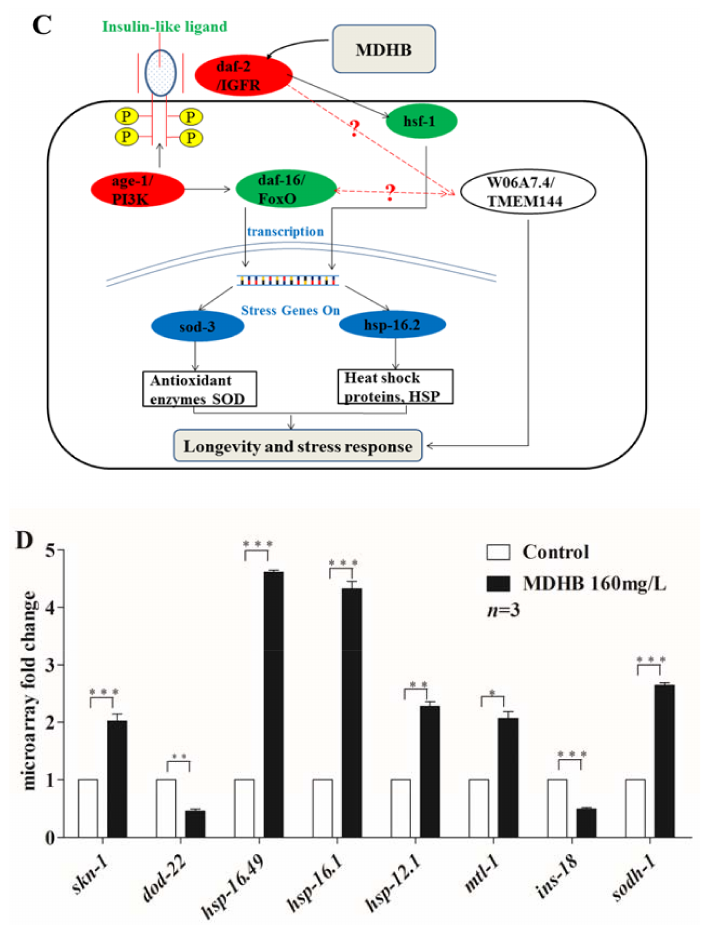
Figure 8. Influence of MDHB on the expression of daf-2/daf-16 target genes. ( A ) Influence of MDHB on survival rates of daf-16 (mu86) mutants under oxidative stress conditions induced by H 2 O 2 . MDHB did not enhance stress resistance in daf-16 (mu86) mutants. ( B ) Influence of MDHB on the expression of hsp-16.2 and sod-3 genes under normal conditions. Green fluorescent protein (GFP) was tested and quantified using a fluorescence multi-reader, and analyzed by the standard Student t -test. ( C ) A drawing of daf-2/daf-16 signaling and its mammalian homologues shows the supposed mechanism of action of MDHB in C. elegans. Active IIS promotes the phosphorylation-dependent cytoplasmic sequestration of the transcription factors daf-16/FoxO and hsf-1 . The insulin/IGF-1 receptor ortholog daf-2 and other pathway components that promote IIS are colored red, and molecules that either antagonize IIS or are antagonized by IIS are colored green. Genes that are promoted by daf-16/FoxO are colored blue. Molecular, which may either promote or antagonize the activity of its target genes, are marked with black arrows. Genes that either antagonize daf-2/daf-16 or are antagonized by daf-2/daf-16 are marked with red arrows. Abbreviations: IIS, insulin/insulin-like growth factor-1 signaling; IGFR, Insulin-like growth factor 1 receptor; PI3K, phosphoinositide 3-kinase; FoxO , forxhead box protein O; P, the phosphate groups. ( D ) Influence of MDHB on the expression of partial daf-2 / daf-16 pathway targets. The effects of MDHB on the expression of genes were detected through a microarray profiling analysis. * p < 0.05; ** p < 0.01; *** p < 0.001; ns: not